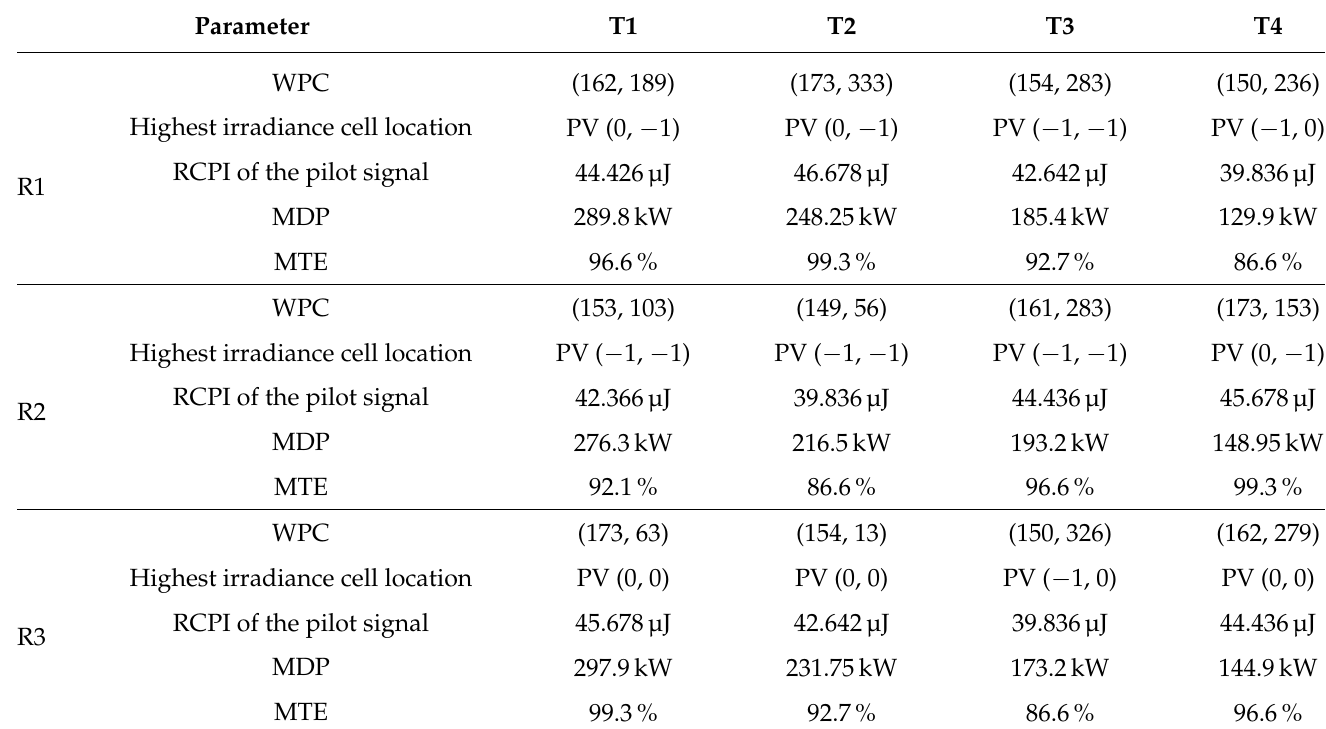
Table 6. Possible PTX-PRX combinations according to the maximum receivable